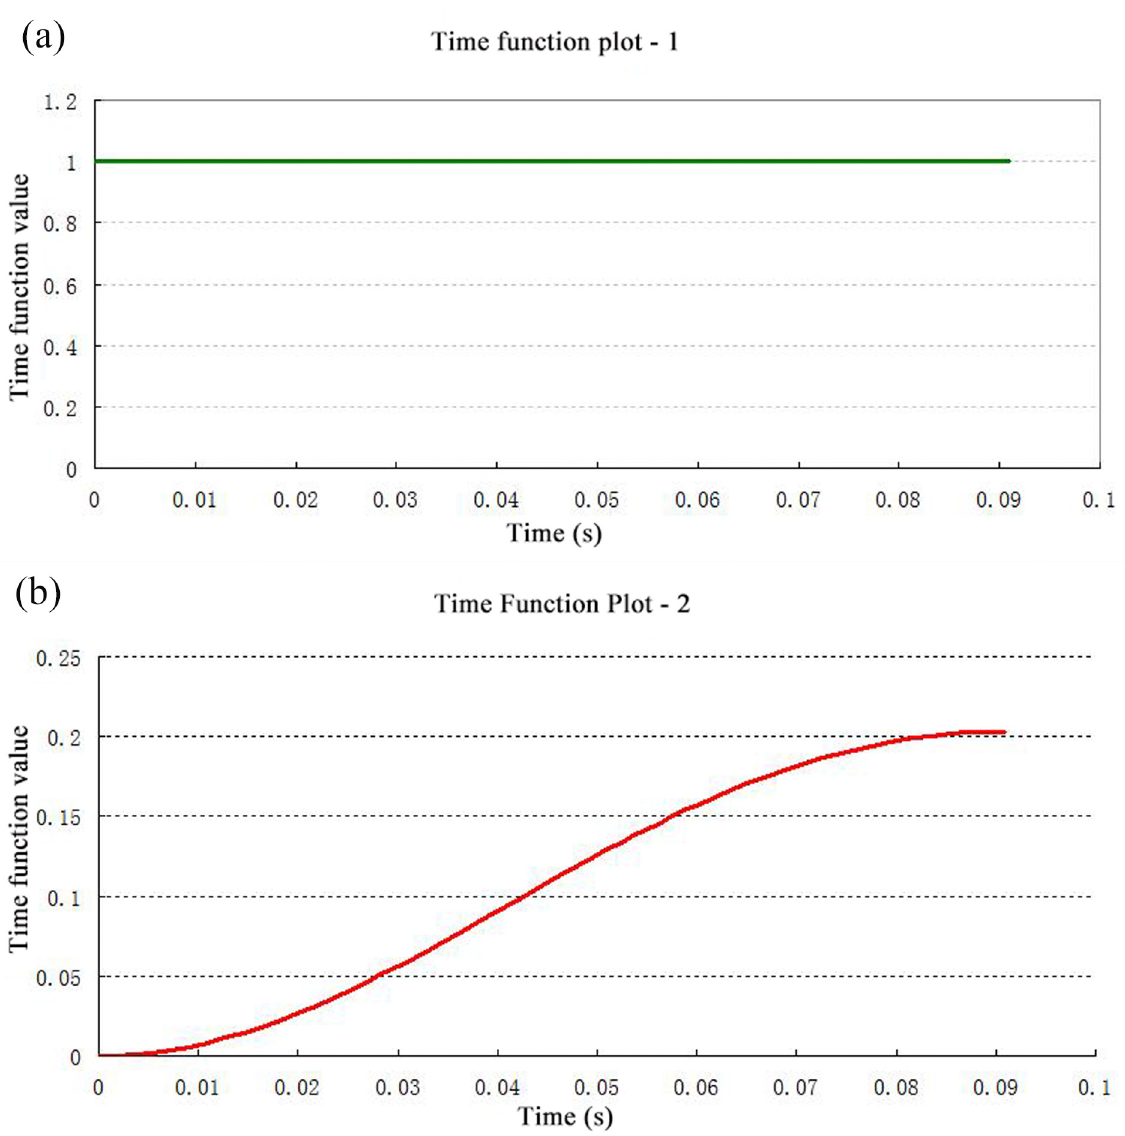
Fig 6. Time function for pump valve cycle. a) Time function definition for loading forces; b) time function definition for moving wall